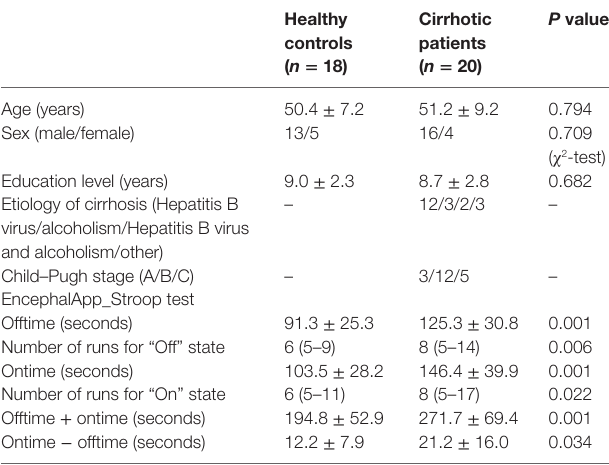
TaBle 1 | Demographic and clinical characteristics of the